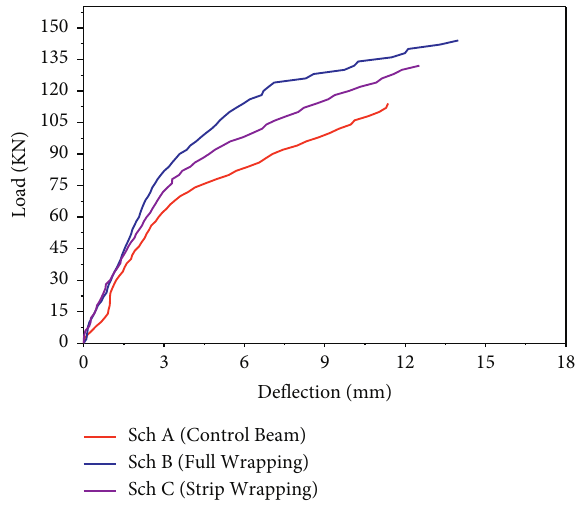
Figure 7: Load-deflection (average mid span) for all Table 3: Deformability indices for beams designed to fail under flexure.